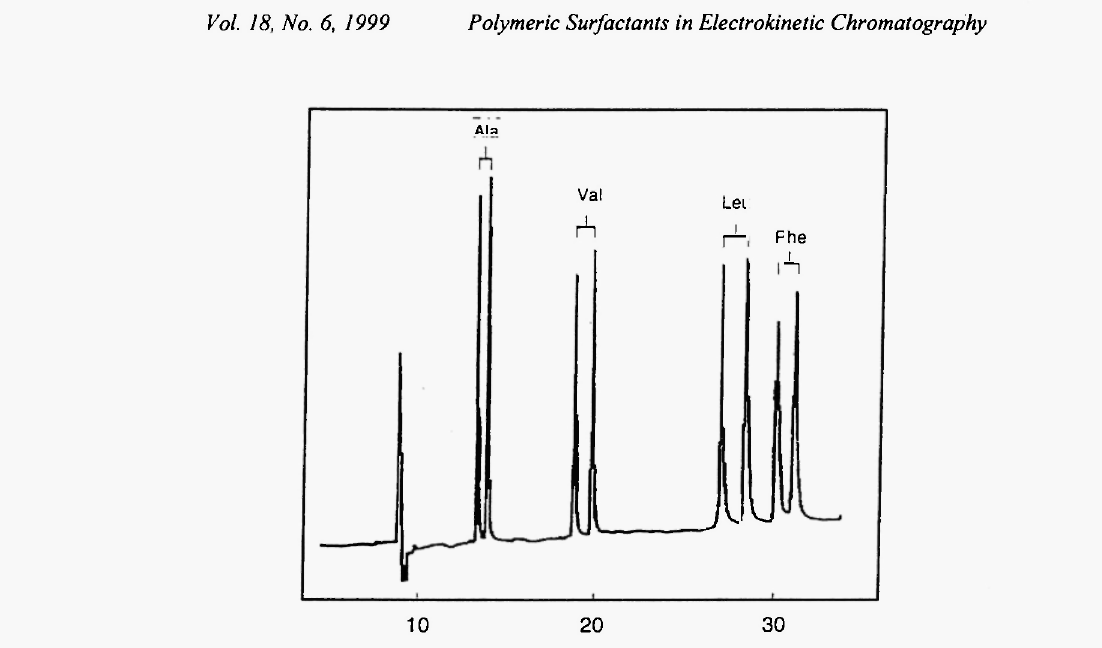
Fig. 15: Separation of a mixture of four (3,5-dinitrobenzoyl) amino acid isopropyl esters with poly(sodium 10-undecanoyl-2-valinate). Experimental conditions: fused silica capillary, 50 cm in length (50 mm i.d.); 25 m \M poly-L-SUV in 25 m Μ borate - 25 mM phsosphate buffer, pH 7.0, containing 2 Μ urea and 10 mM SDS; total applied voltage, ca. 12.4 - 12.8 kV, detection UV at 254 nm. From 757/ with